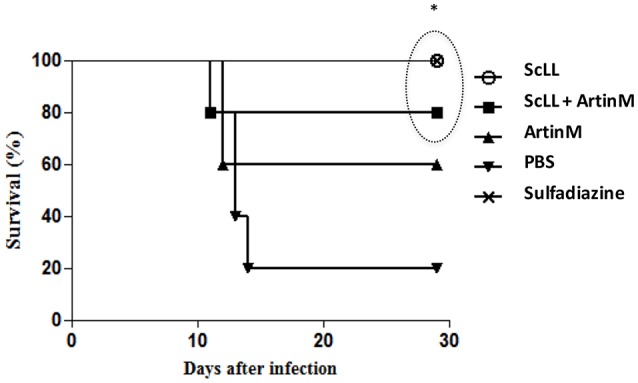
Survival curve of C57BL/6 mice after infection with T. gondii ME49 strain. Animals were treated with ScLL, ArtinM, ScLL plus ArtinM, or sulfadiazine during 6 days, one time a day. As control, animals were infected with the same strain, but treated with phosphate-buffered saline (PBS) only. The survival curves were compared using the Log-rank Mantel-Cox test. Values of P < 0.05 were considered statistically significant. *Indicates significant differences (P < 0.05).